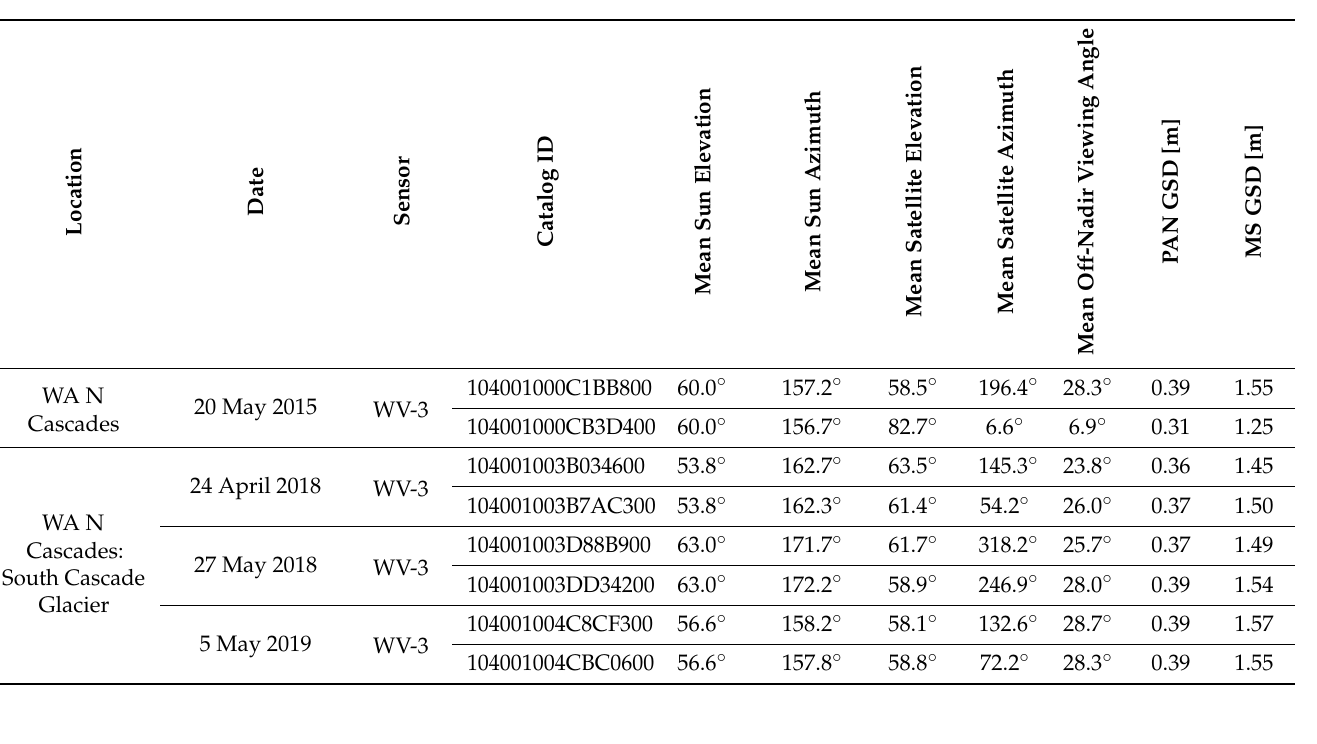
Table 1. Metadata for WorldView-2 (WV-2) and WorldView-3 (WV-3) images analyzed in this study. Ground sample distance (GSD) is a measure of the ground-projected distance between the center of two adjacent